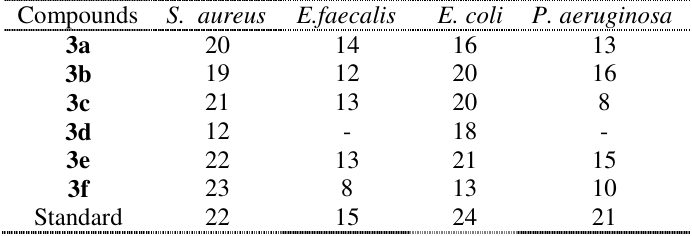
Table 2. Antibacterial activity of the compounds (3a-3f) Compounds S.